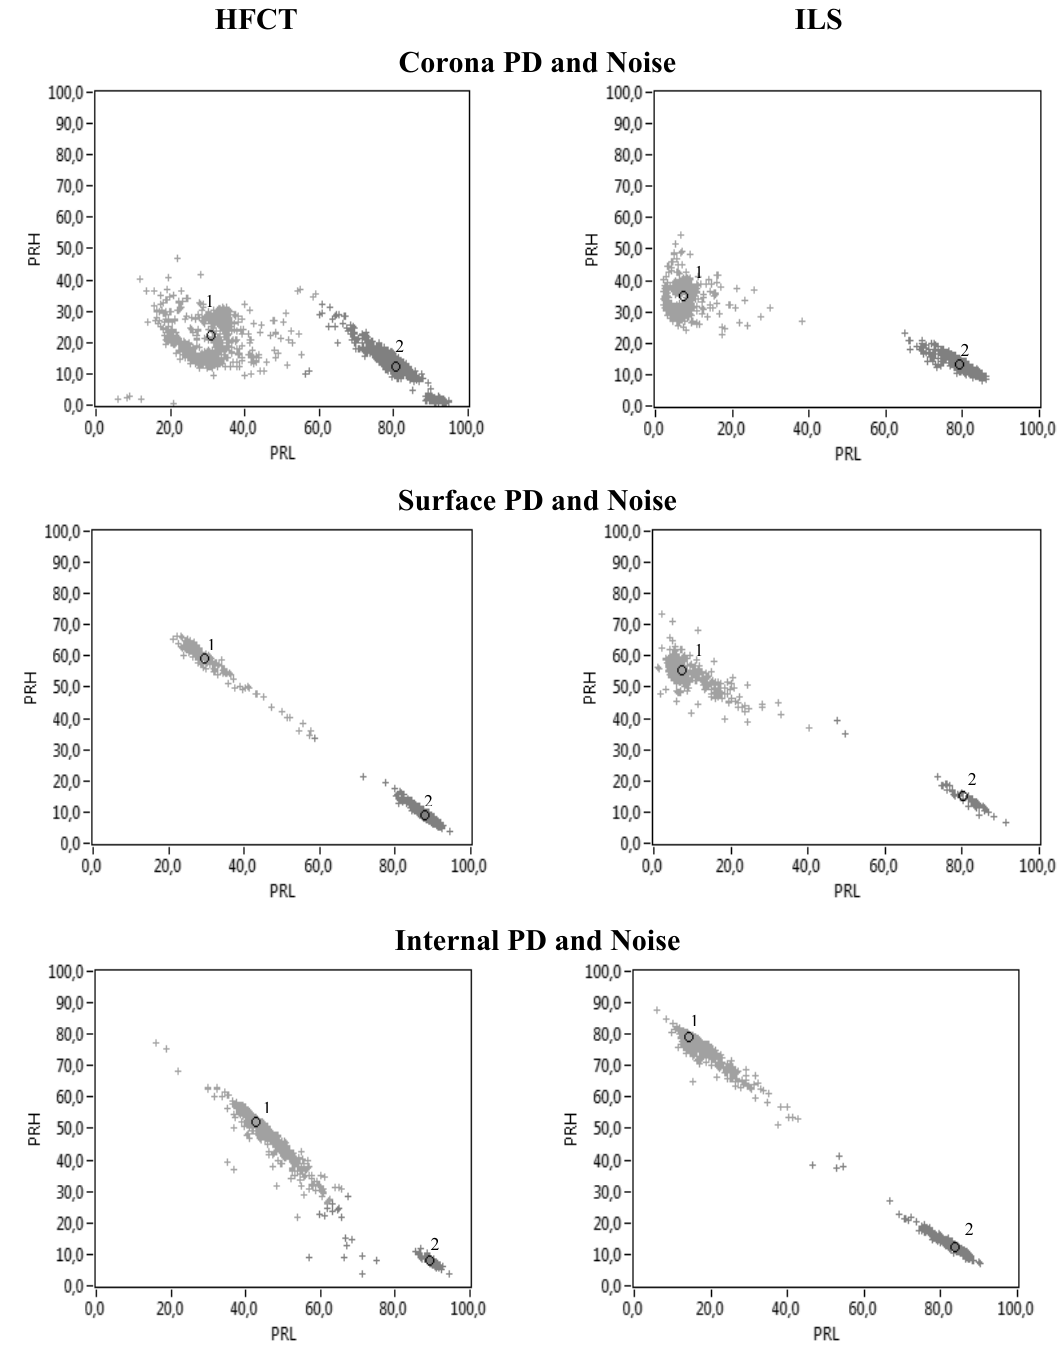
Figure 13. PR maps for PD (cluster 1) and noise (cluster 2) obtained with both